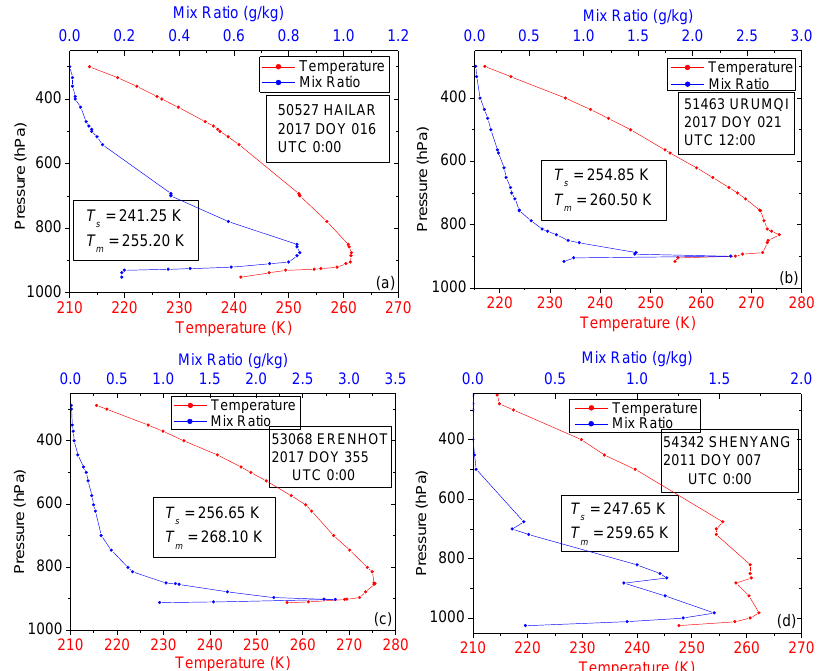
Figure 13. Representative vertical profiles of temperature (red) and water vapor mixing ratio (blue) from radiosonde observations that satisfy T m − T s > 10 K at station ( a ) HAILAR, ( b ) URUMQI, ( c ) ERENHOT, and ( d ) SHENYANG. The radiosonde observing time as well as T s and T m are shown in each panel.